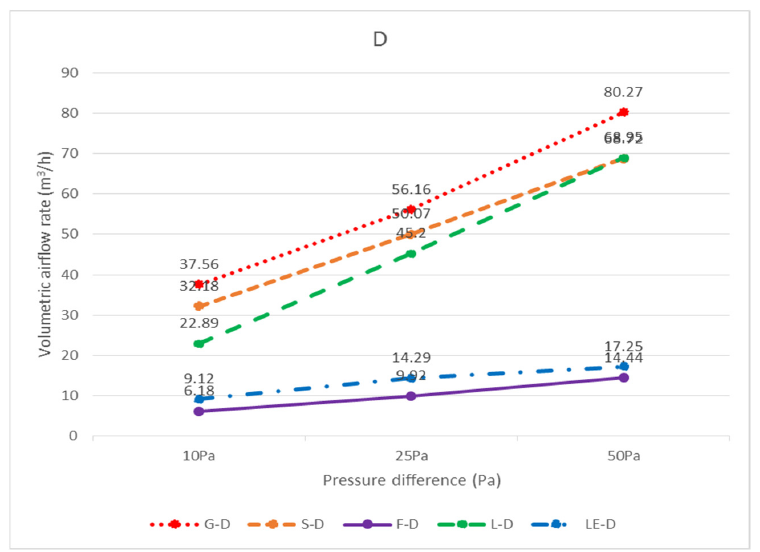
Figure 12. Average leakage of each specimen at each pressure difference from top to bottom (D) (m 3 /h).